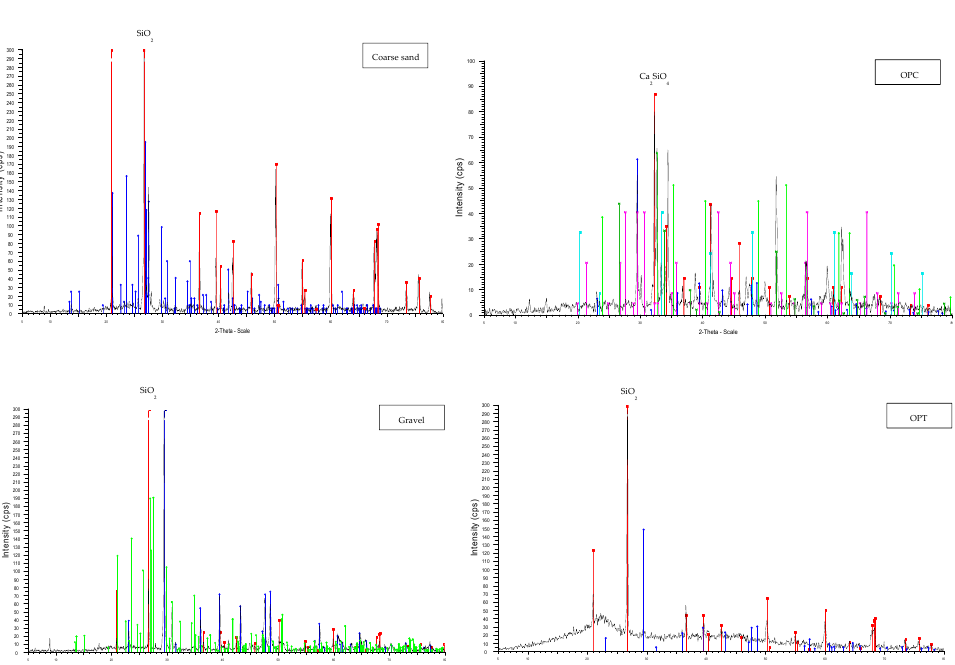
ff ractometer (XRD) pattern of raw materials. Figure 2. X-ray diffractometer (XRD) pattern of raw materials. Figure 2. X-ray di Figure 2. X-ray diffractometer (XRD) pattern of raw materials.